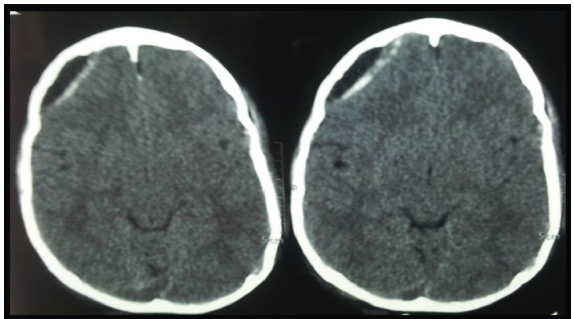
Figure 4: Postoperative CTscan showing subdural hemorrhage in temporoparietal